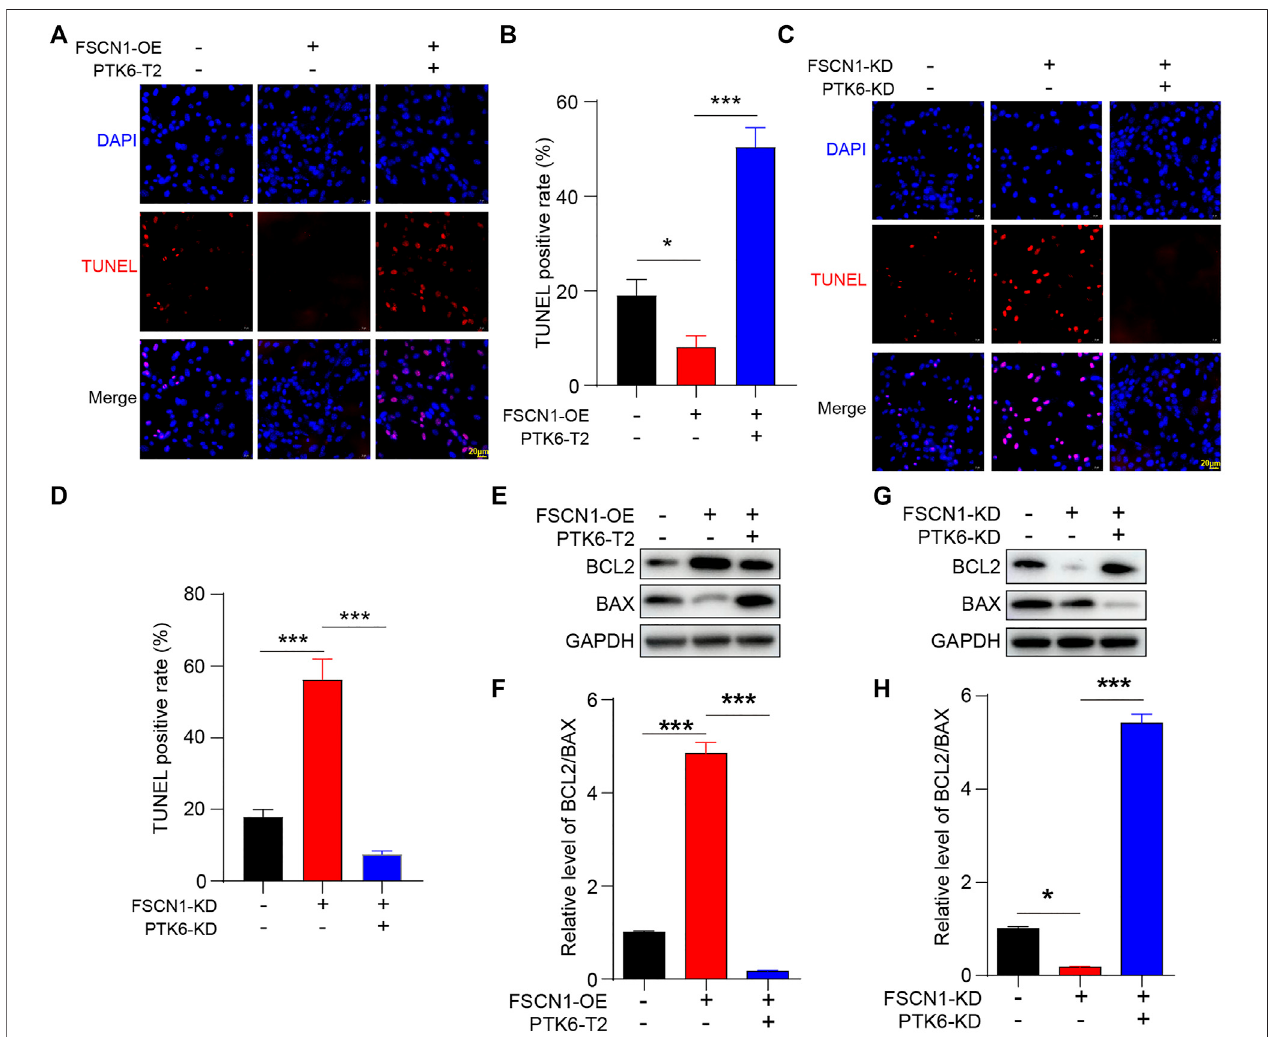
FIGURE 4 | PTK-T2 increases ECA-109 apoptosis. (A) ECA-109 cells expressing NC, FSCN1-OE, and FSCN1-OE + PTK6-T2 as indicated were stained by TUNEL. (B) Statistical analysis of A. n = 3 per group, * p < 0.05, *** p < 0.001. (C) ECA-109 cells expressing NC, FSCN1-KD, and FSCN1-KD + PTK6-KD as indicated were stained by TUNEL. (D) Statistical analysis of C. n = 3 per group, *** p < 0.001. (E) ECA-109 cells expressing NC, FSCN1-OE, and FSCN1-OE + PTK6-T2 as indicated were harvested. BCL2 and BAX were detected by western blotting. (F) Statistical analysis of E. n = 3 per group, *** p < 0.001. (G) ECA-109 cells expressingNC,FSCN1-KD,andFSCN1-KD+PTK6-KDasindicatedwereharvested.BCL2andBAXweredetectedbywesternblotting. (H) StatisticalanalysisofG. n = 3 per group, * p < 0.05, *** p <